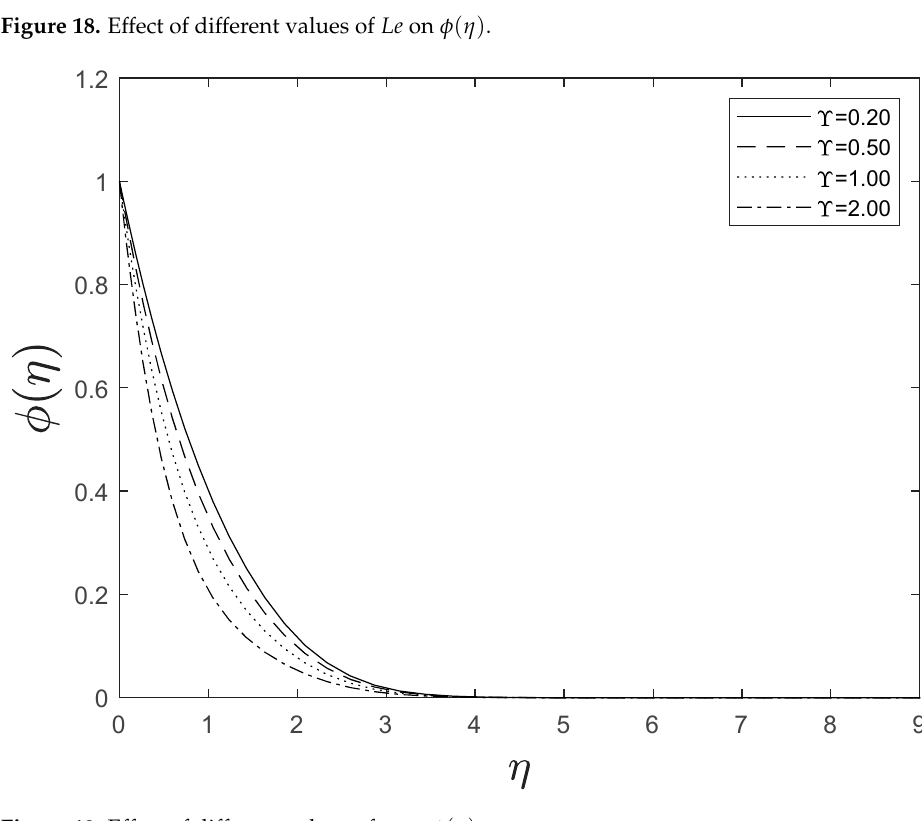
Figure 19. Effect of different values of γ on φ ( η )